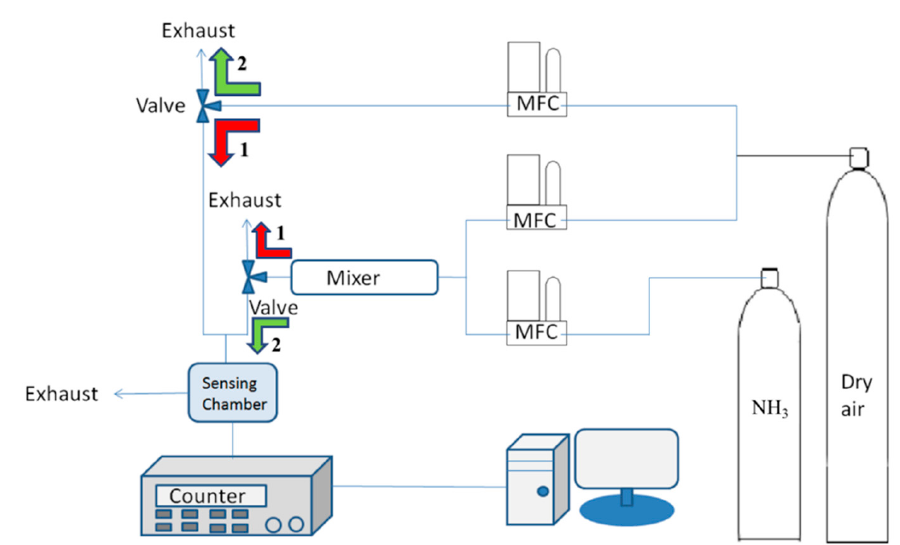
Figure 3. Experimental setup for ammonia gas sensing measurement.